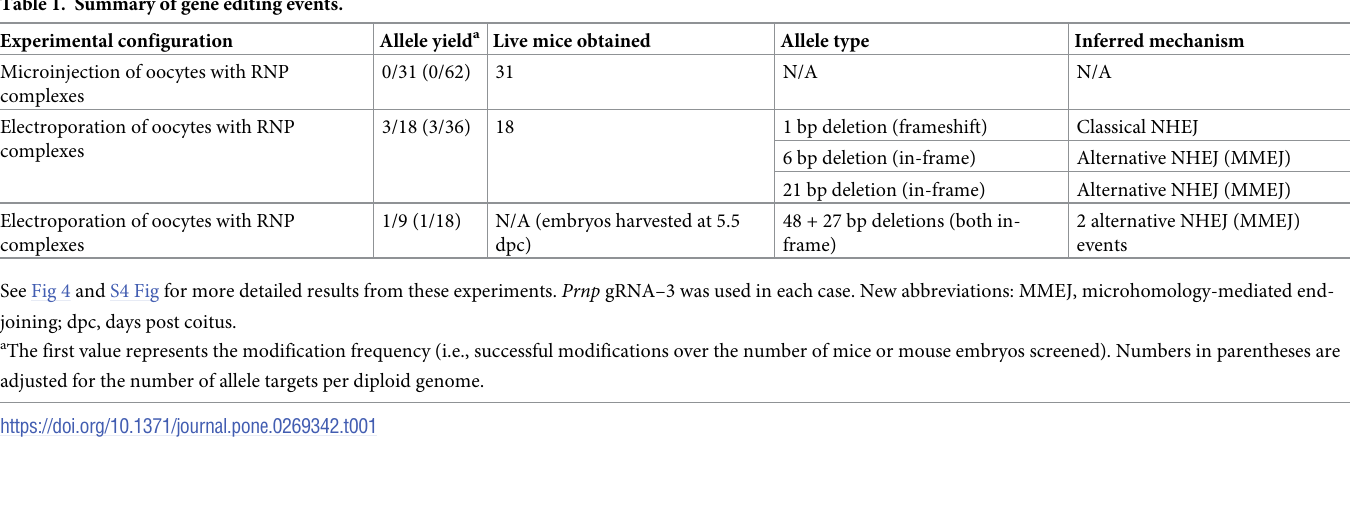
Table 1. Two attempts at microinjecting recCas9/ Prnp gRNA–3 RNP complexes (tracrRNA/